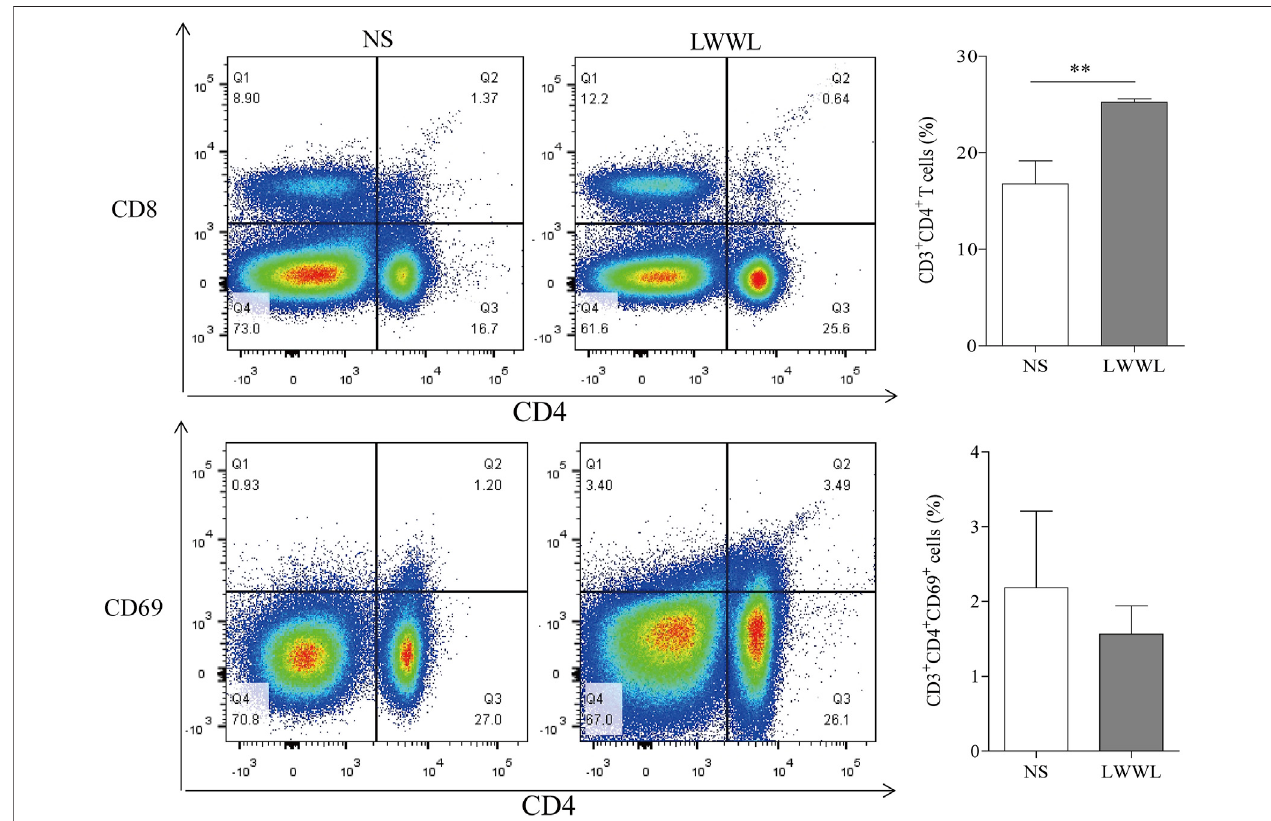
FIGURE 5 | Effect of LWWL on splenic T cells of pAAV-HBV1.2 replication mice. Flow cytometry of the frequencies of CD4 + T cells (A) and CD4 + CD69 + T-cell subsets (C) ingatedCD3 + T-cellsetofspleenlymphocytesarepresentedforrepresentativepAAV-HBV1.2replicationmicefromNS-treatedandLWWL-treatedgroups. Statistical analysis of the frequencies of CD3 + CD4 + T-cell subset (B) and CD3 + CD4 + CD69 + T-cell subset (D) was performed to see if there was signi fi cant difference between LWWL-treated group and NS-treated group. NS, normal saline; LWWL, Liuweiwuling Tablet. * p < 0.05, ** p < 0.01.